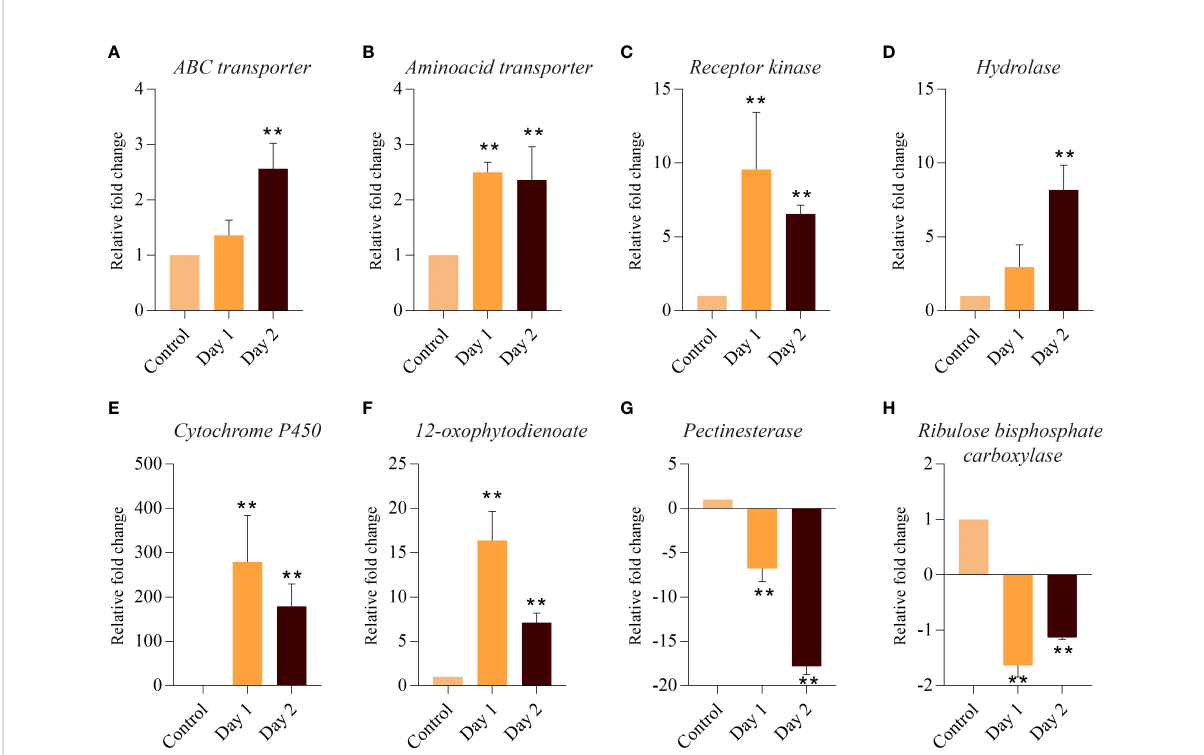
FIGURE 5 Quantitative PCR-based validation of DEGs associated with coleoptile senescence in rice. Relative expression of genes belonging to functional categories such as transporters: ABC transporter (A) , amino acid transporter (B) ; signaling: Receptor kinase (C) ; hormone signaling and transduction: Hydrolase (D) , cytochrome P450 (E) and 12-oxophytodienoate (F) ; cell wall: Pectinesterase (G) ; and photosynthesis: Ribulose bisphosphate carboxylase (H) was determined in control and at day 1 and day 2 of senescing coleoptiles. For normalization eEF-1 a was used as an internal control. Three biological replicates and two technical replicates were included in the study. Asterisks indicate a signi fi cant difference between the control and the senescence sample (Student ’ s t -test, ** P <